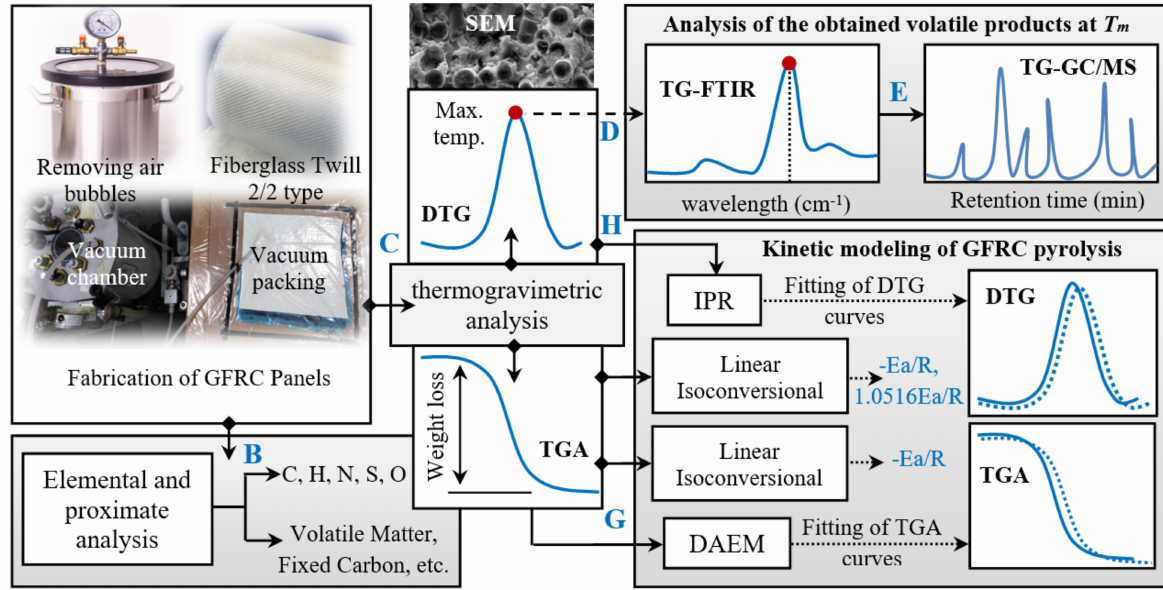
Figure 1. The layout of the present